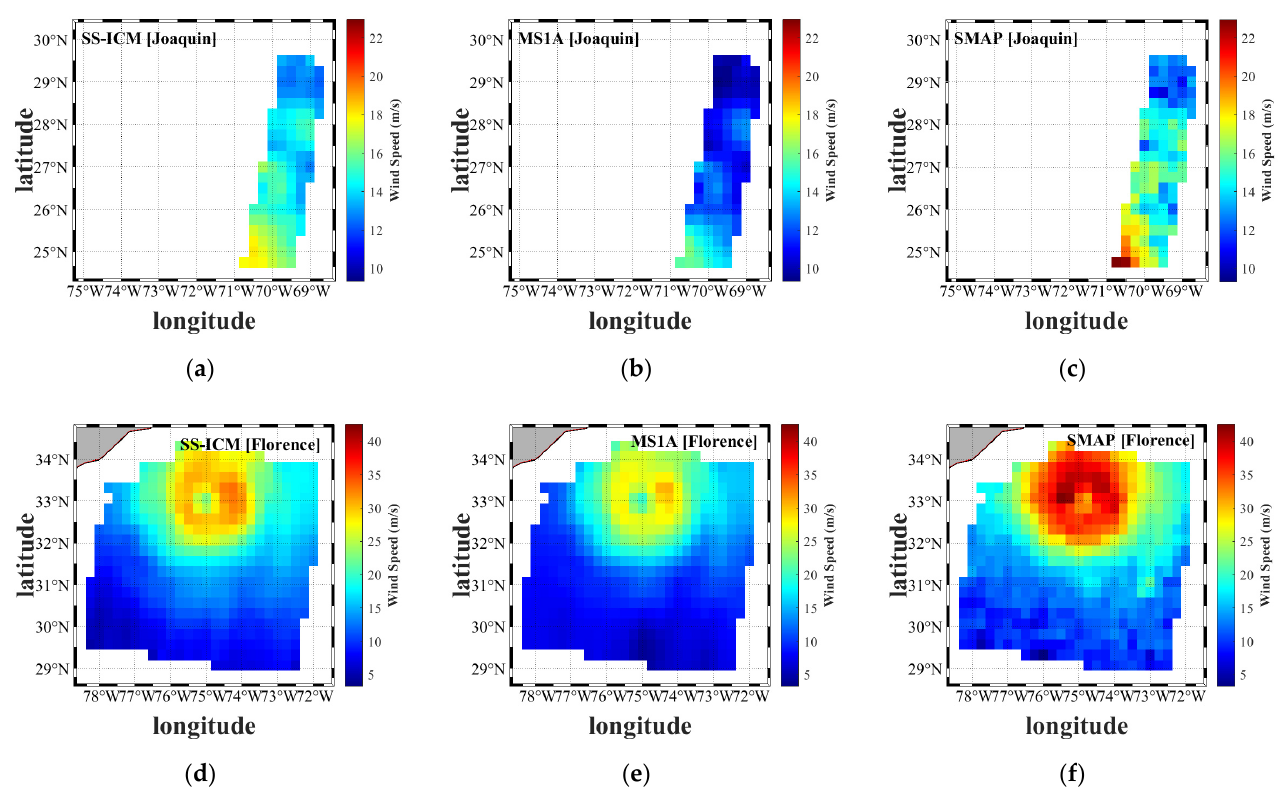
Figure 16. Wind speed retrieved by the SS-ICM, MS1A model, and wind speed from SMAP, corresponding to ( a – c ) TC Joaquin images and ( d – f ) TC Florence.